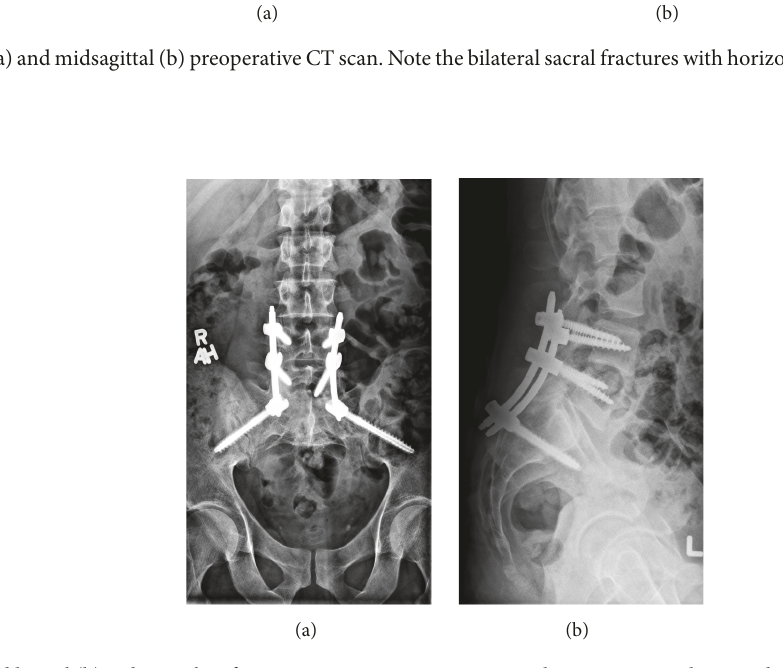
Figure 2: AP (a) and lateral (b) radiographs of patient seen in Figure 1 at 16 months postoperatively treated with percutaneous fixation. Note the resolution of kyphotic deformity with consolidation of fracture